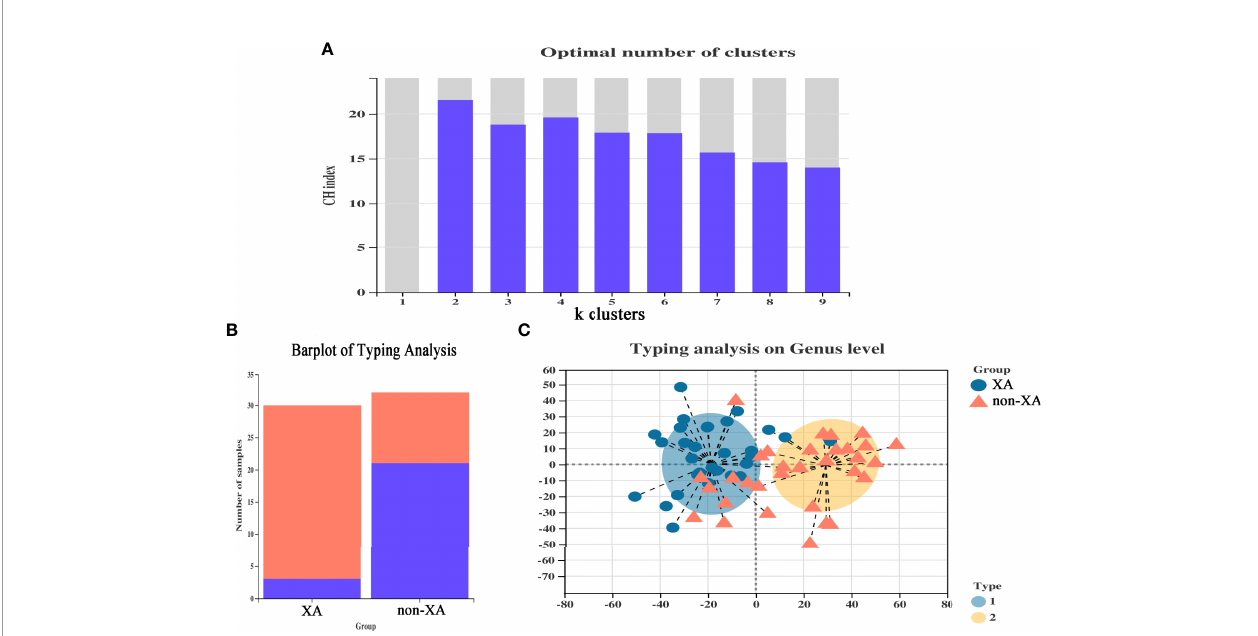
FIGURE 3 | Enterotype analysis of xerostomia patients. (A) CH index map, selected the number of clusters when the CH index reaches the maximum to classify the oral microbiota, and optimal classi fi cation is achieved when divided into two community types. (B) The classi fi cation of each group of samples constitutes a histogram, and different colors represented different classi fi cations. (C) The plot of PCoA of salivary samples using partitioning around medoids. PCoA, principal coordinate